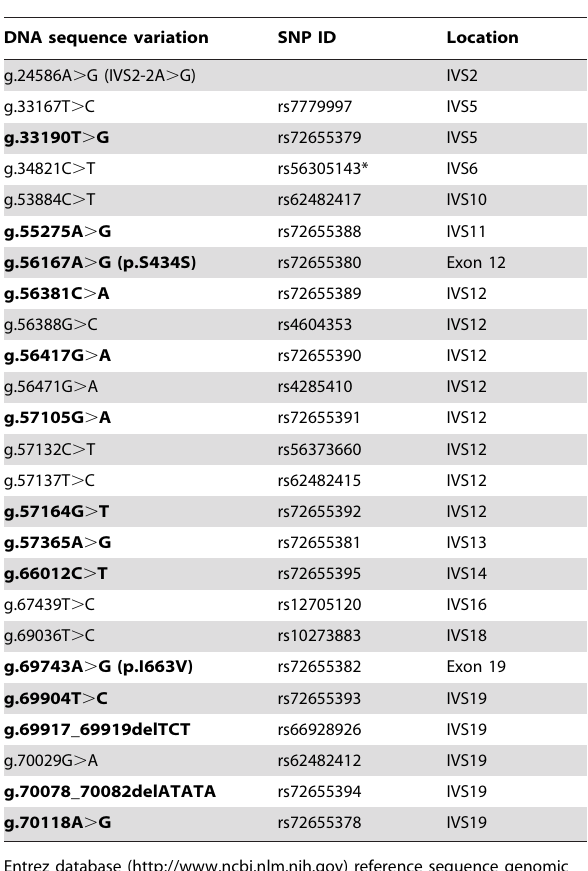
Table 1. DNA sequence variations in SLC26A5